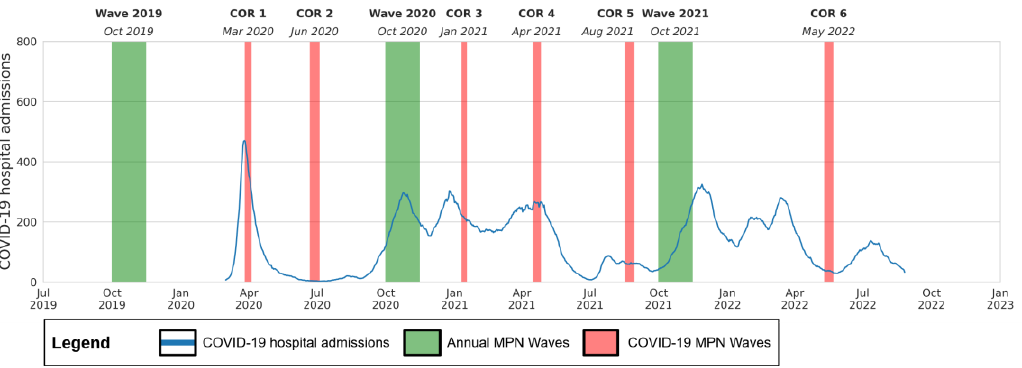
Figure 2. MPN measurements in relation to COVID-19